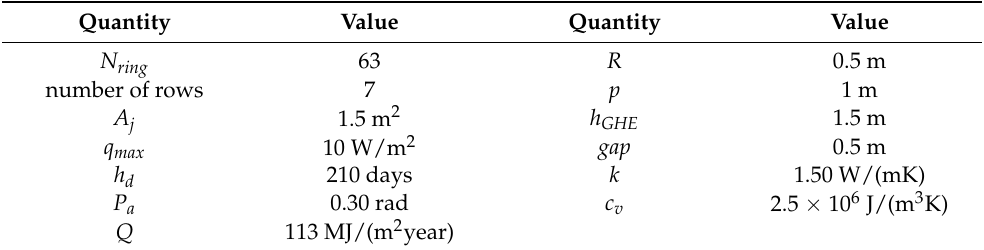
Table 2. Numerical values used in calculations of the ground temperature field with an installed slinky-coil exchanger.